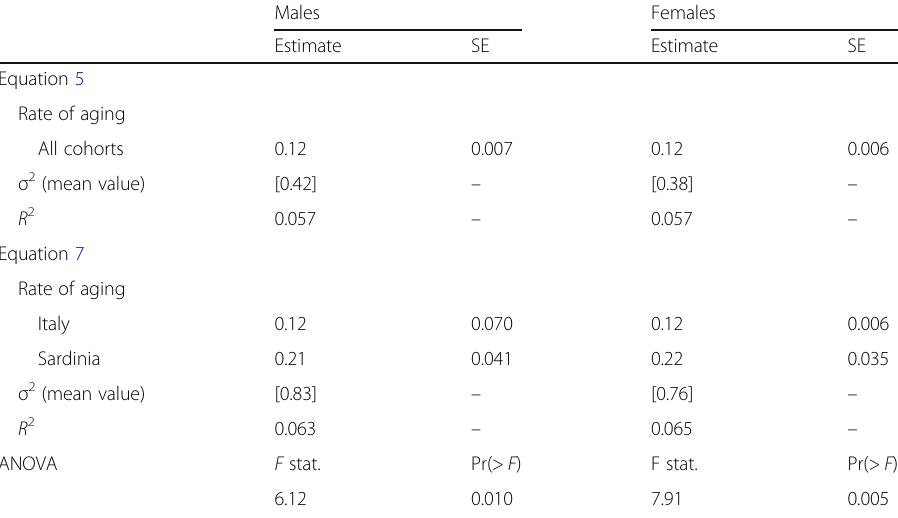
Table 3 Comparison between the Italian and the Sardinian rate of aging before the onset of the epidemiological transition Males